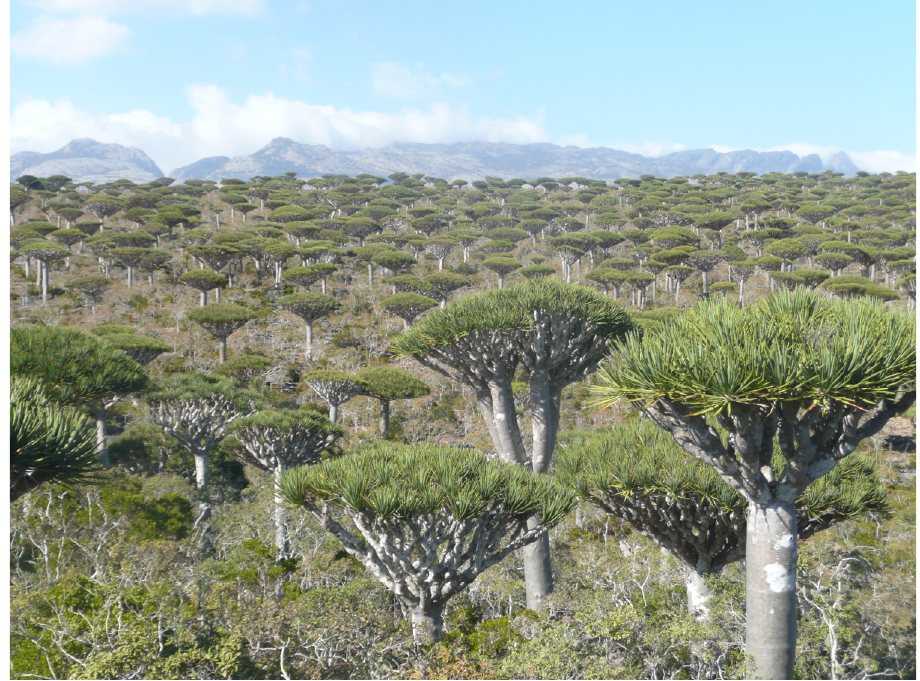
Figure 1. Part of the Dracaena cinnabari forest on Firmihin Plateau (H. Habrová, 2011).